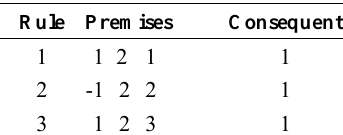
Table 4: Example 2: Set of candidate rules to be compacted when a premise has a -1 value.